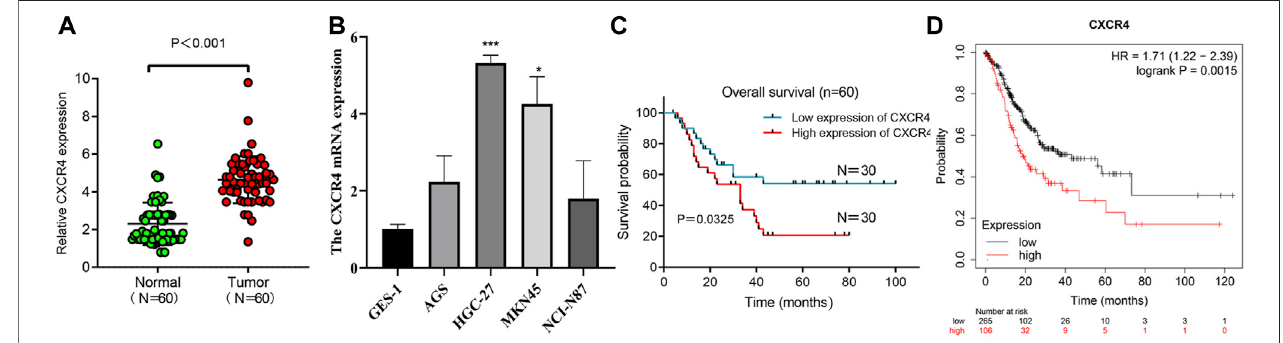
FIGURE6 | CXCR4 expression inGC. (A) The expression ofCXCR4 inGC tissues and paracancerous tissues. (B) CXCR4 expression inGC celllines. (C) Survival analysis of CXCR4 in GC patients. (D) survival curve of CXCR4 based on Kaplan Meier